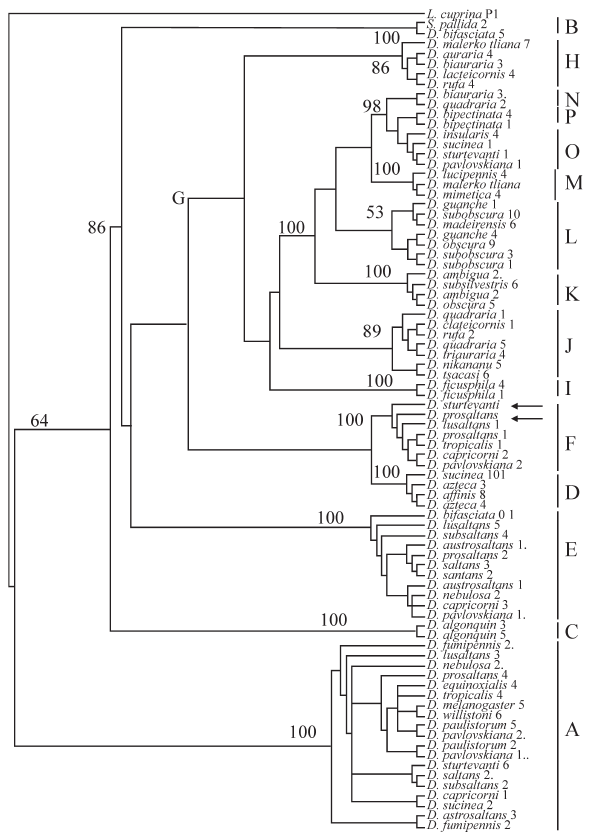
Figure 1 - Cladogram of P element nucleotide sequences obtained in this studyandthosepublishedbyClarkandKidwell(1997).Speciesnamesare given followed by the total number of clones used to obtain a consensus sequence or, for the sequences obtained in our study, an arrow. This is a consensus tree of 1,000 equally parsimonious trees each requiring 2,193 steps. Of 449 characters, 34 were constant, 60 uninformative, and 355 par- simony informative. The consistency index is 0.40 and the retention index 0.815. Bootstrap analysis of 500 replicates was performed on the data. Clades names were given by Clark and Kidwell (1997) and are shown on the